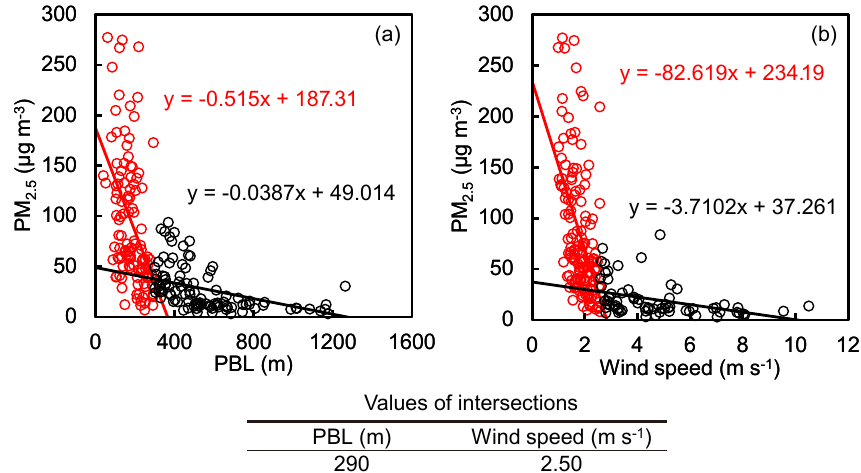
Figure 5. Scatter plot showing the correlation between daily PM 2 . 5 concentrations ( y axis) and (a) daily PBL heights ( x axis) and (b) daily wind speeds ( x axis) during the sampling periods. The red and black scattered points represent different distribution areas. The piecewise function regression equations and the corresponding values of PBL height and wind speed according to the intersections are